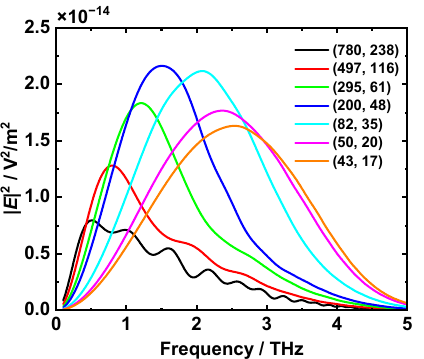
Figure 3. Terahertz intensity generated by RQPM OR with different 1 mm-thick polycrystalline ZnSe samples. The grain size distribution is written as ( μ , σ ), where μ and σ are the mean value and standard deviation in micron, respectively. The cross section for the (780, 238) sample was 3 × 3 mm 2 , it was 2 × 2 mm 2 for the (497, 116) and (295, 61) samples, and it was 1 × 1 mm 2 for all the left samples.